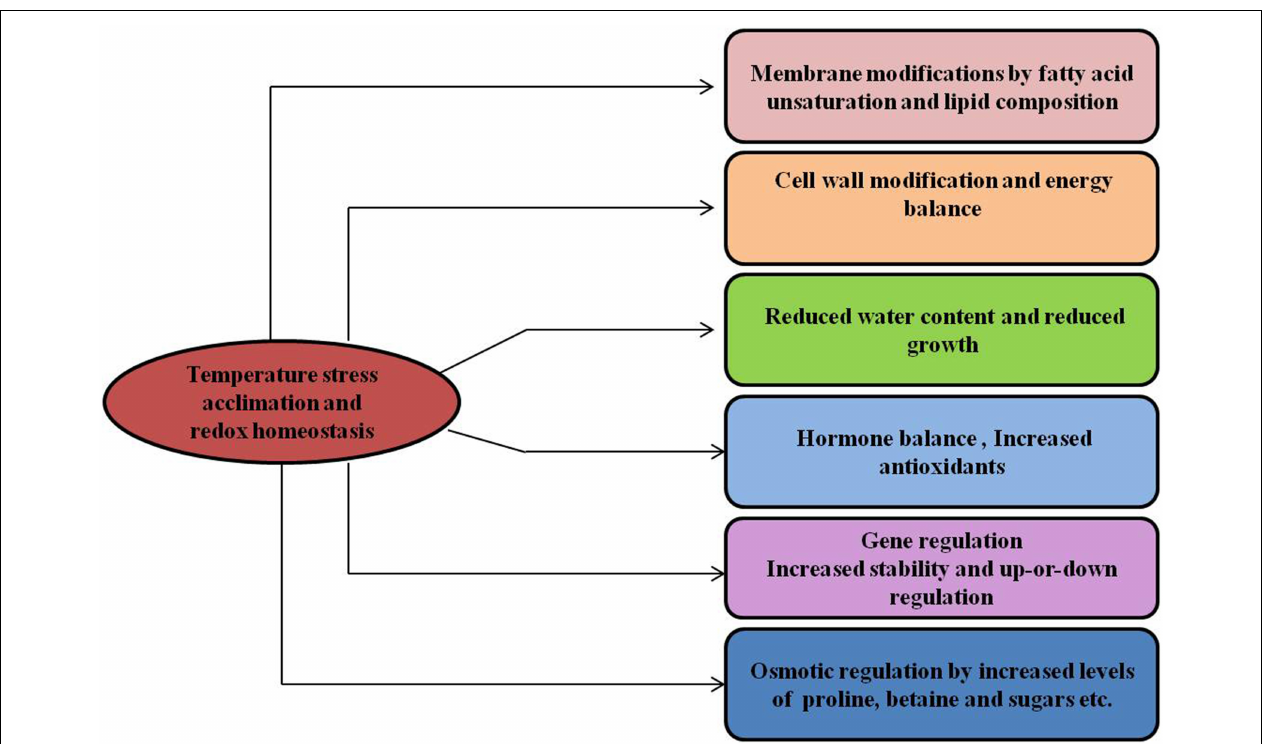
FIGURE 6 | Temperature stress and metabolic homeostasis. Temperature stress acclimation induces changes in many different cellular processes, provides stress tolerance and maintains the cellular redox state in